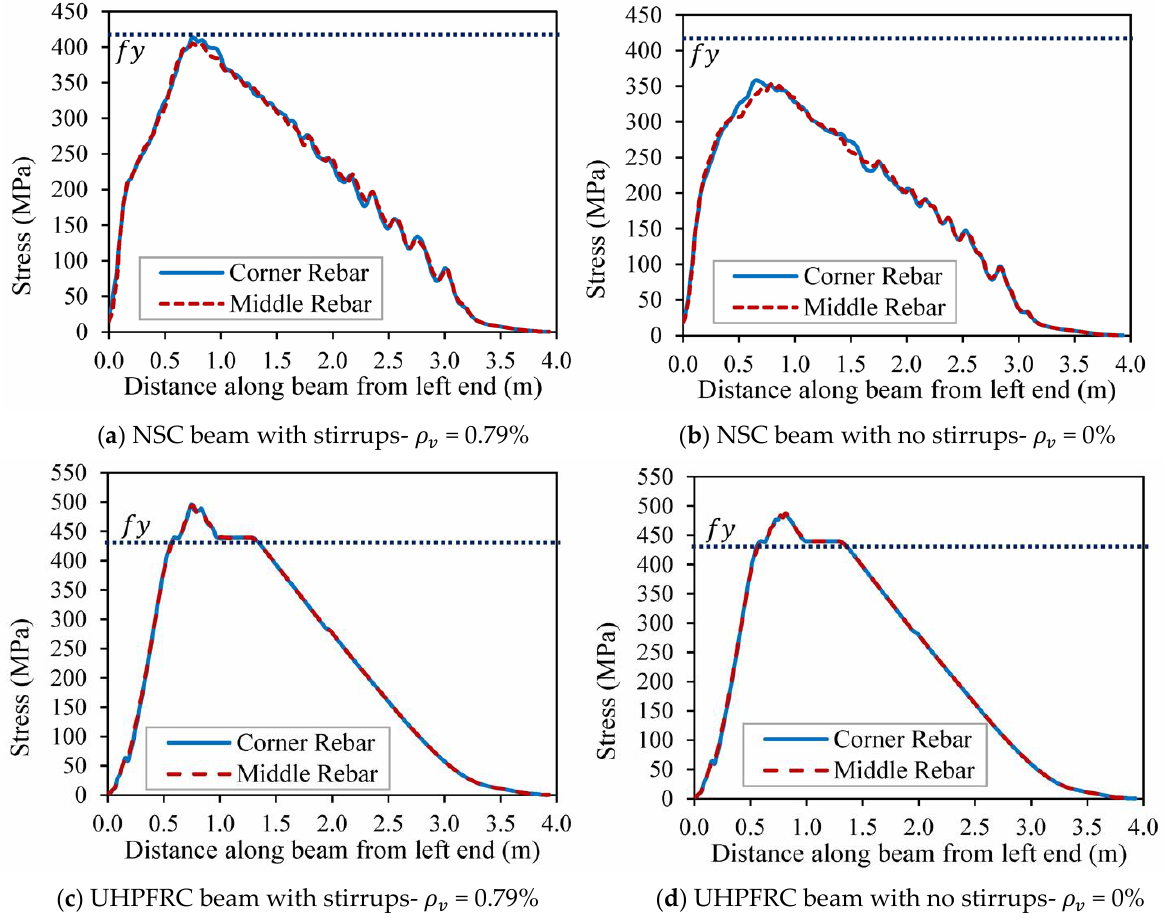
Figure 11. Stress distribution in longitudinal reinforcing bars in NSC and UHPFRC beams (with cross section similar to U-B4- 𝜌 𝑡 = 0.90%) along the beam length.